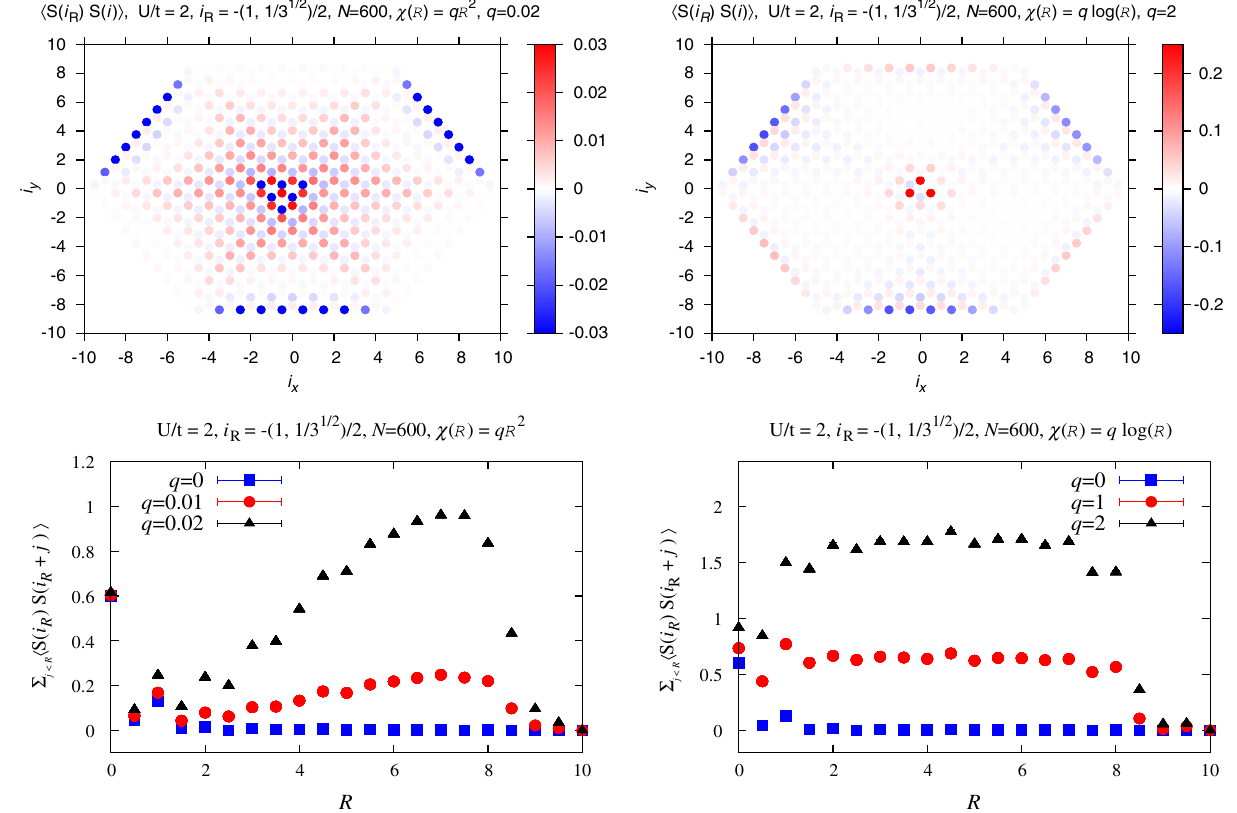
FIG. 6. Quantum Monte Carlo simulations on a 600-site flake. The top panels plot the spin-spin correlation functions between the ffiffiffi p 3 Þ and other sites of the lattice for both the uniform χ ð R Þ ¼ q R 2 and local χ ð R Þ ¼ q log ð R Þ axial reference point i R ¼ ð − 1 = 2 ; − 1 = 2 fields. The two bottom panels plot the integrated spin-spin correlations S ð R Þ , defined in Eq. (12), exhibiting, at finite values of q , edge- compensated antiferromagnetic spin